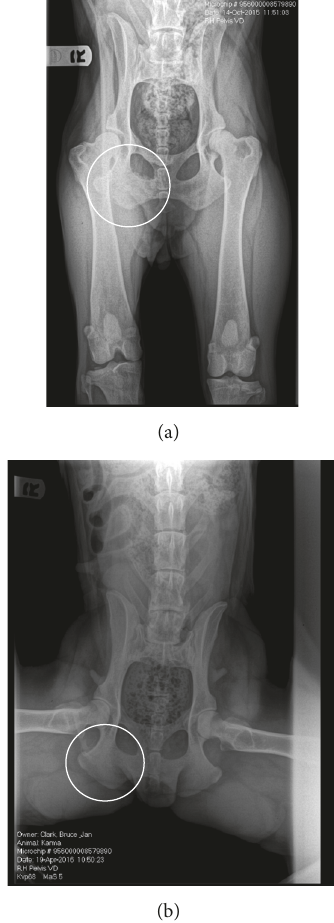
Figure 3: Radiographs of a dog with soft tissue sarcoma before and after treatment with high dose DHEA. Note the right ischial soft tissue sarcoma (a) which completely resolved as a result of treatment